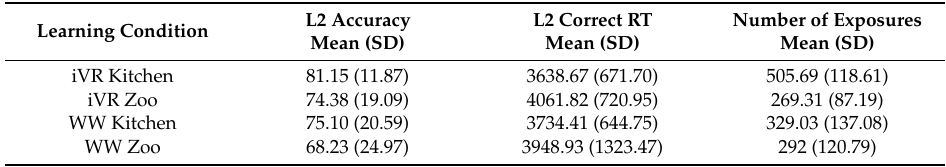
Table 2. Overview of means and standard deviations (SD) for L2 accuracy, reaction time (RT), and number of exposures for each L2 learning condition. Average L2 accuracy scores denote the mean percentage of correct responses per